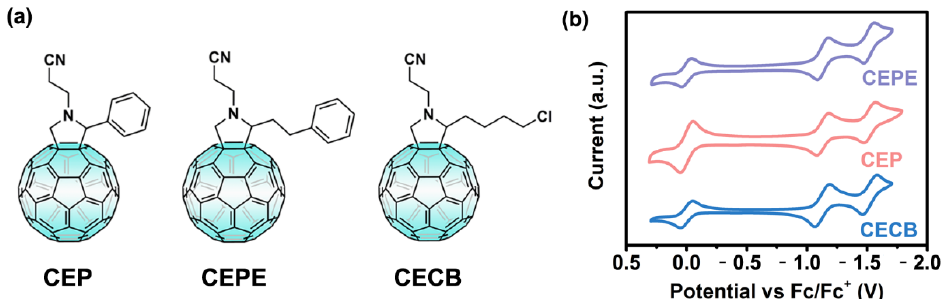
Figure 1. ( a ) Chemical structures and ( b ) CV curves of CEP, CEPE and CECB in a mixed solution of o -DCB/acetonitrile (5:1, v / v ) with 0.1 M Bu 4 NPF 6 at a scan rate of 100 mV/s. Fc/Fc + was used as the internal standard.